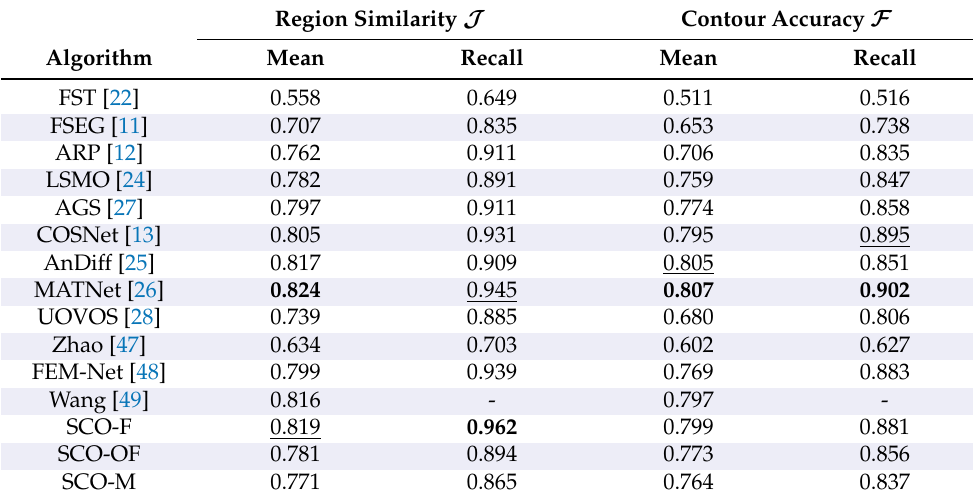
Table 6. Comparison of the proposed SCO algorithm with the conventional unsupervised VOS algorithms on the validation set in DAVIS2016. The best results are boldfaced, and the second best ones are underlined.